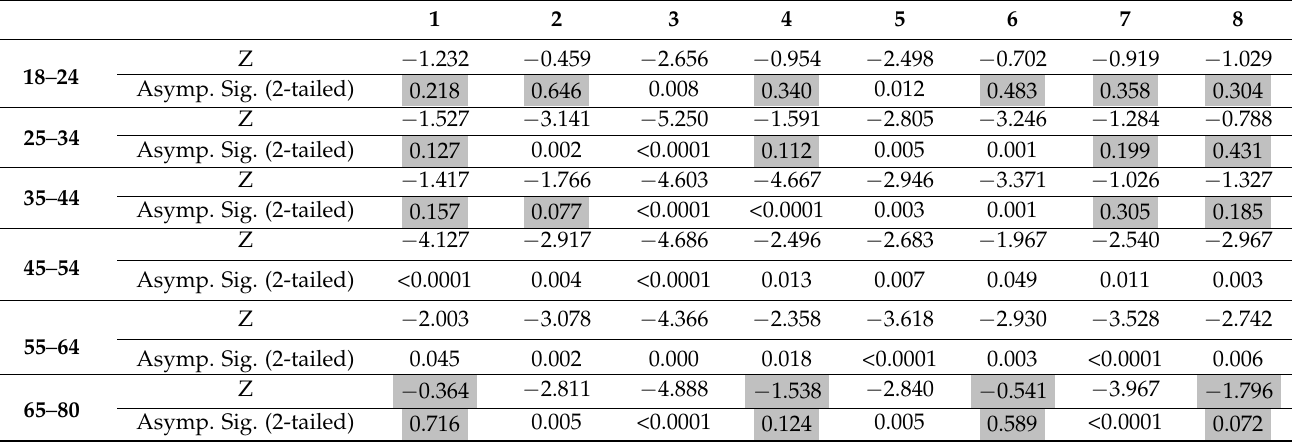
Table 8. Age-based consumer attitudes.